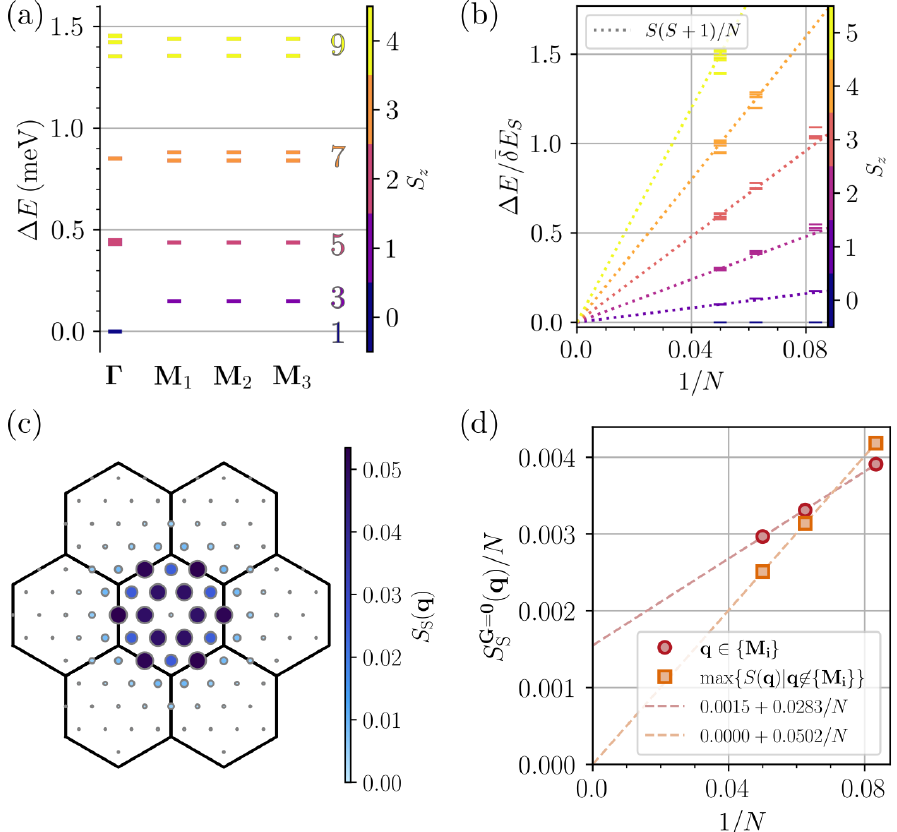
{ w “ 0. AA AB form a tower of states j structure z j